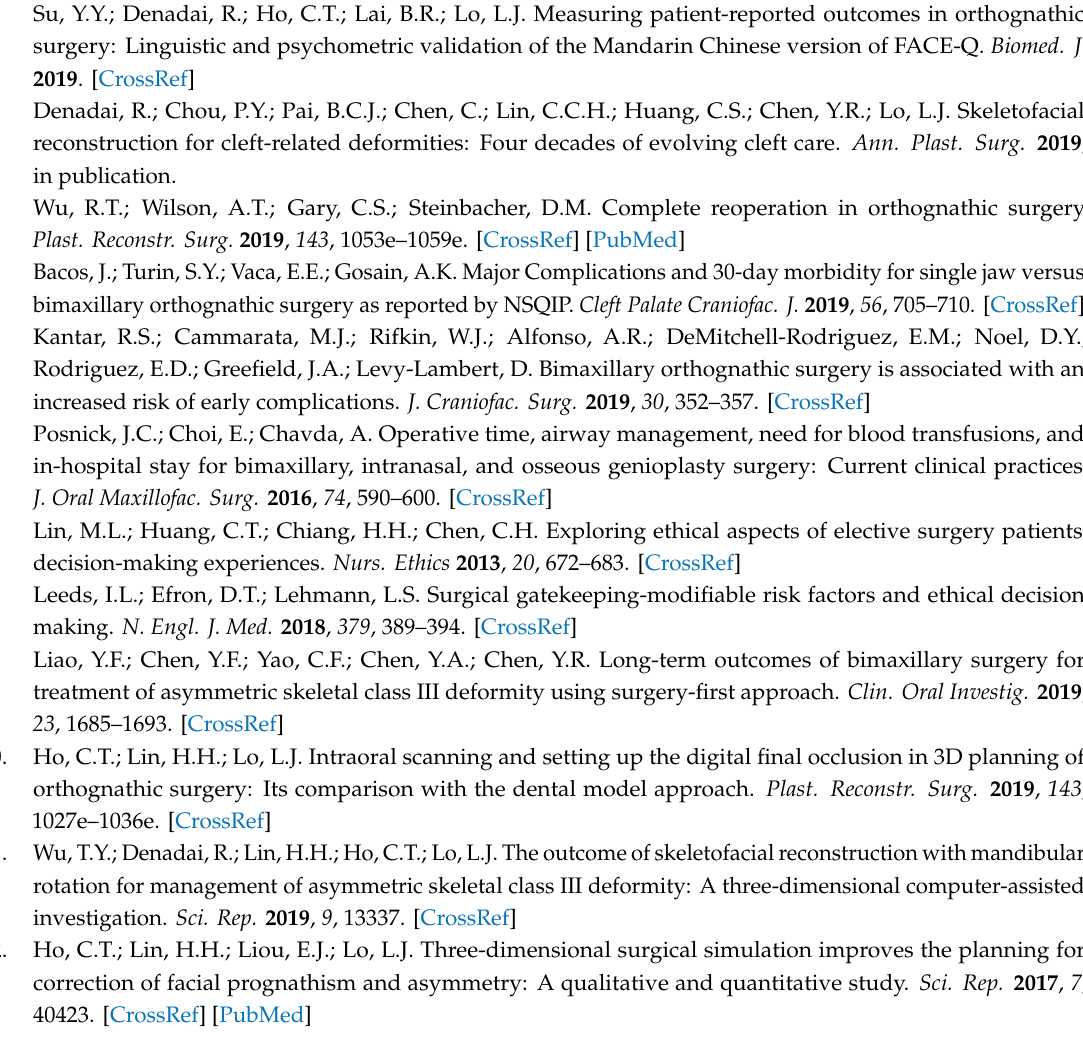
Table S1: Comprehensive Multidisciplinary Team-Based Orthognathic Surgery Approach. Table S2: Condition- Specific Practical Guidelines for Perioperative Care. Table S3: Characteristics of Patients with Underlying High-Risk